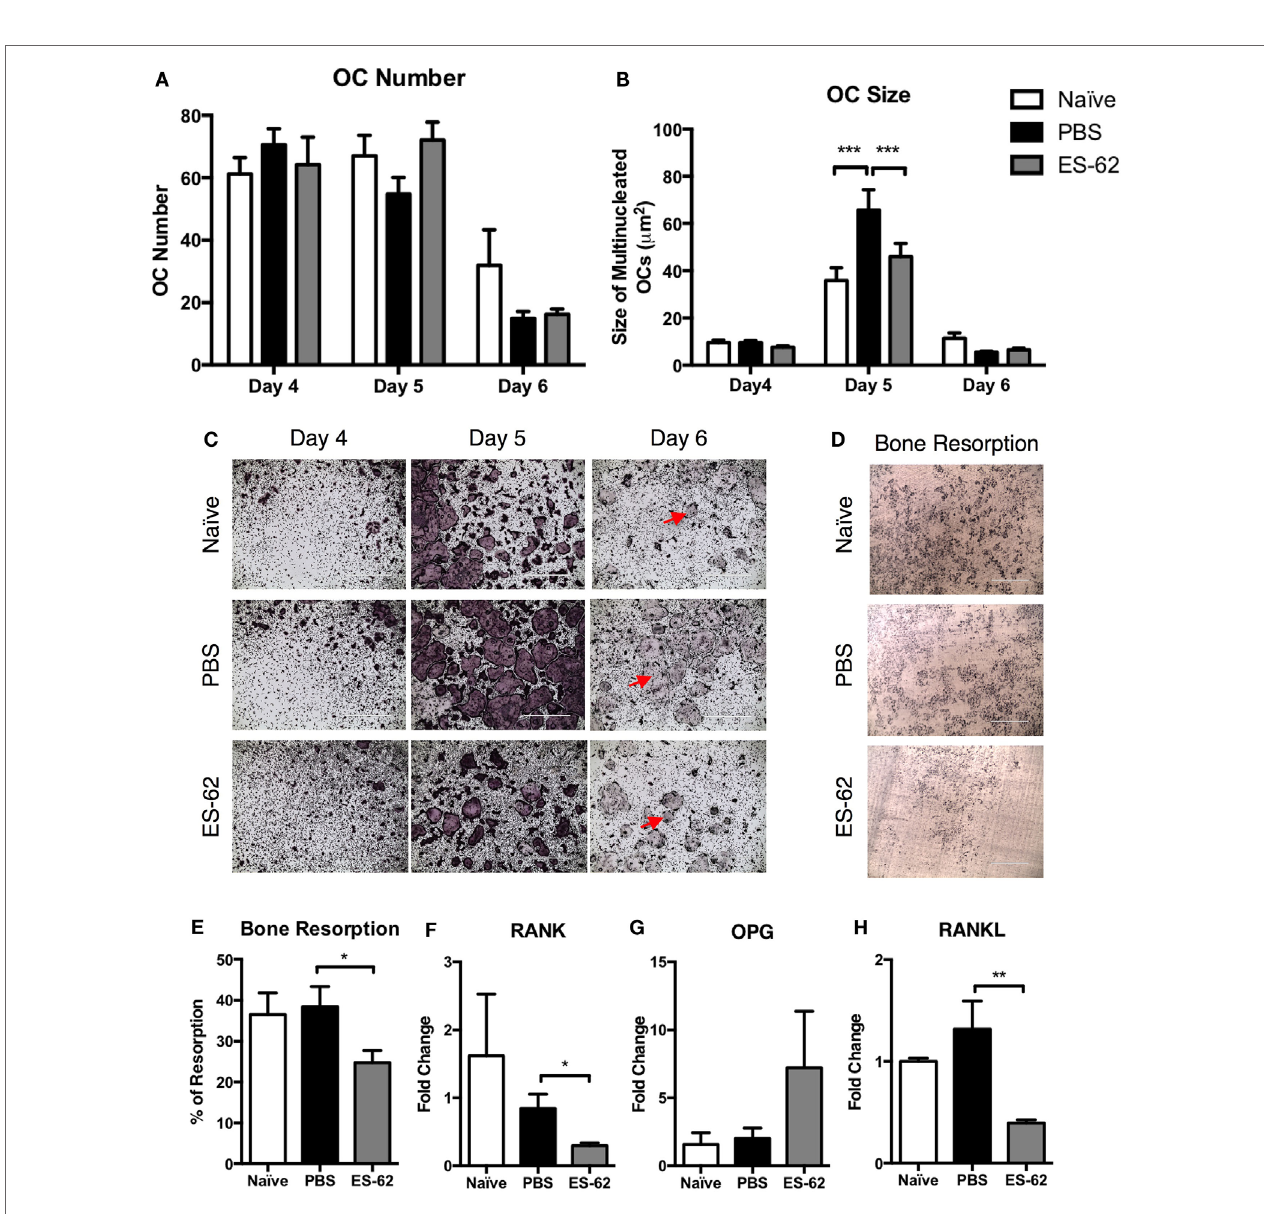
FigUre 1 | ES-62 alters the progenitor populations in the BM of arthritic animals. Arthritic scores of DBA/1 mice undergoing CIA from challenge until cull at day 29 (PBS-treated CIA animals, n = 8; ES-62-treated CIA animals, n = 6) (a) and the scores of all animals used in the study obtained from four independent CIA models at cull [PBS-treated ( n = 30) and ES-62-treated ( n = 20) CIA animals] (B) . Joint sections of representative animals (PBS-CIA, score 7 and ES-62-CIA, score 0) in each treatment group were subjected to histological analysis employing H&E staining [ (c) scale bar = 400 µm] and analysis of expression of cathepsin K by immunofluorescence [ (D) DAPI, blue; cathepsin K, red; scale bar = 500 µm]. The number of cathepsin K + multinucleated cells within the joints of animals [naïve ( n = 4), PBS ( n = 3), and ES-62 ( n = 4); three field of view (FOV) per sample] were enumerated (e) . BM was taken from naïve ( n = 8), PBS ( n = 12), and ES-62 ( n = 7) treated CIA animals to analyze the frequency of hematopoietic stem cells (HSCs—Lineage neg Sca-1 + CD117 + ) (F) . QIAzol lysates of bone-lining cells from the femur and tibia of animals were analyzed for osteopontin (OPN) mRNA (naïve, n = 4; PBS, n = 8; ES-62, n = 7) (g) . BM from CIA animals was analyzed by flow cytometry for the phenotypic markers of monocytes and OC precursors (OCPs) following gating of single CD3 − B220 − Ter119 − cells. The gating strategy for distinguishing monocytes from neutrophils is demonstrated (Ly6C high Ly6G − population) and this is subsequently used to identify the OCPs (CD11b low Ly6C high Ly6G − population) that reside within the global monocyte population (h) . The percentage of monocytes and OC precursors (i,J) from naïve ( n = 24), PBS-treated [ n = 26 for (i) and 30 for (J) ], and ES-62-treated ( n = 19) CIA animals as well as the expression of CD115 on the surface of monocytes and OC precursors [( K,l ); naïve, n = 4; PBS, n = 8; ES-62, n = 7] was examined. Data are pooled from four independent experiments and are presented as mean values of individual mice ± SEM. Two-tailed Mann–Whitney t -test or Kruskal–Wallis with Dunn’s multiple comparisons was used for non-parametric data and one-way ANOVA with Fishers LSD was used to analyze parametric data where * p < 0.05, ** p < 0.01, and *** p <